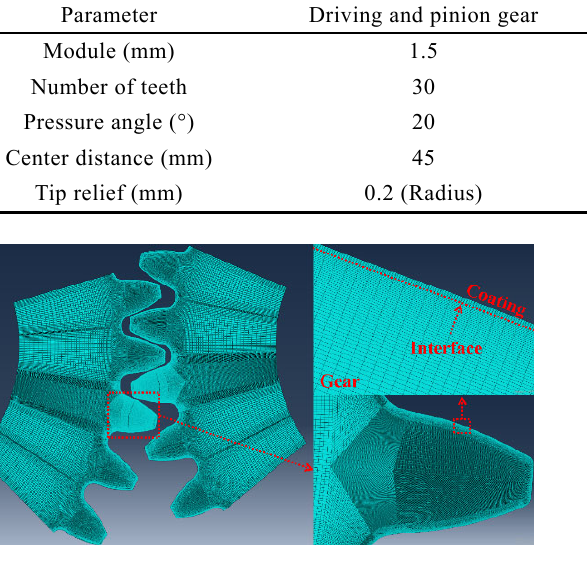
Fig. 1 Assembled gear set with densely discretized pair of gear